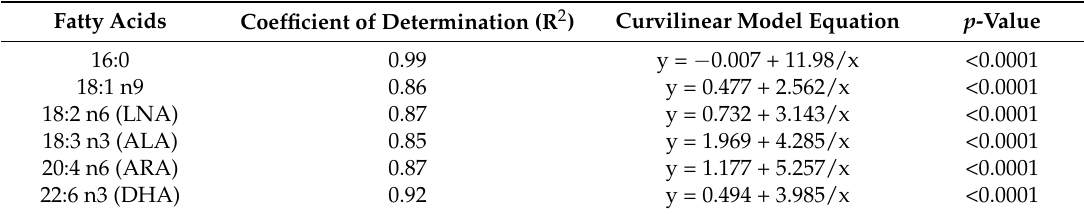
Table 3. Curvilinear regression models to predict loss of some selected fatty acids after 24 h of HM infusion. ALA: α -linolenic acid; LNA: linoleic acid; AA: arachidonic acid; DHA: docosahexaenoic